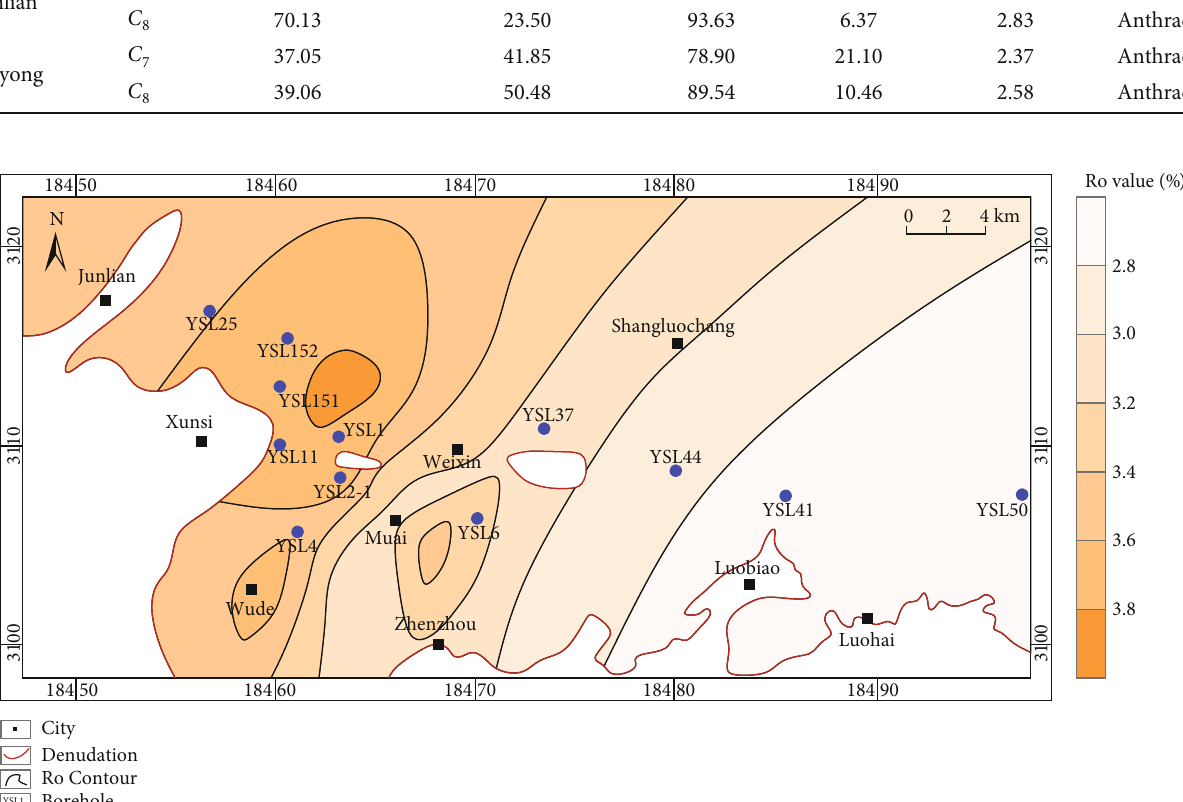
Figure 8: R O contour map of Lopingian